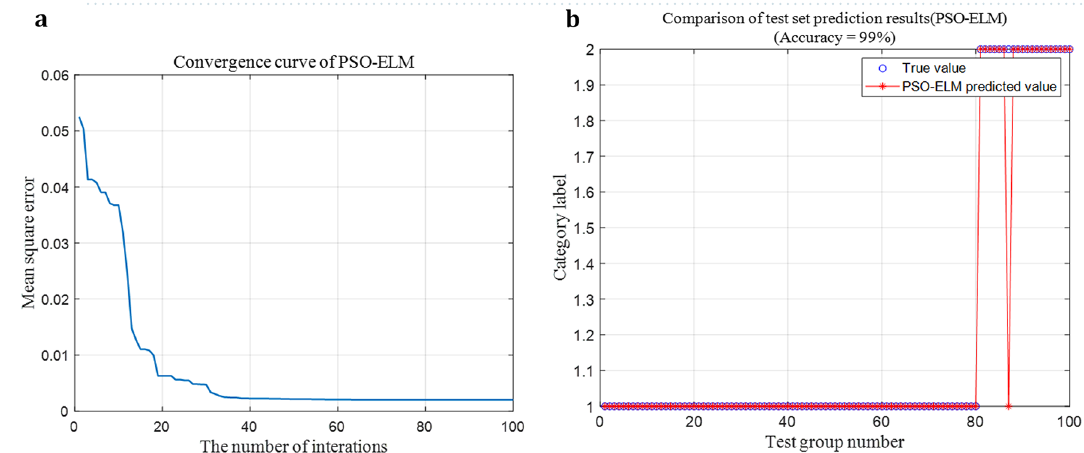
Figure 13. Fault diagnosis effect of PSO-ELM. ( a ) Convergence curve of PSO-ELM. ( b ) Fault diagnosis accuracy of